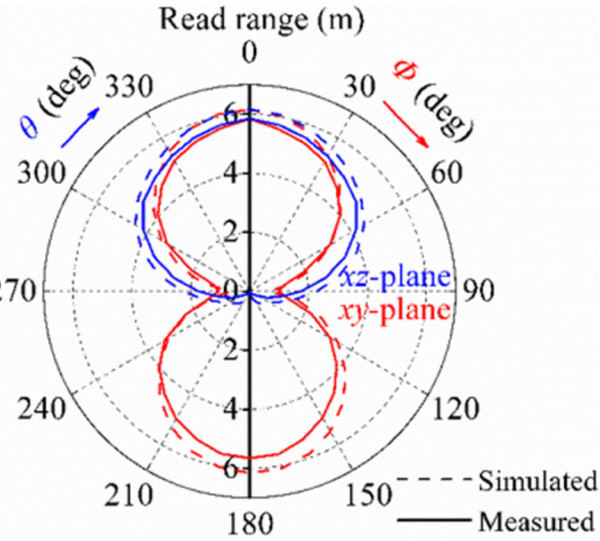
Figure 13. Simulated and measured radiation patterns in terms of the read range of the tag on a 20 × 20 cm 2 flat copper plate at 915 MHz in xy plane and the xz plane.